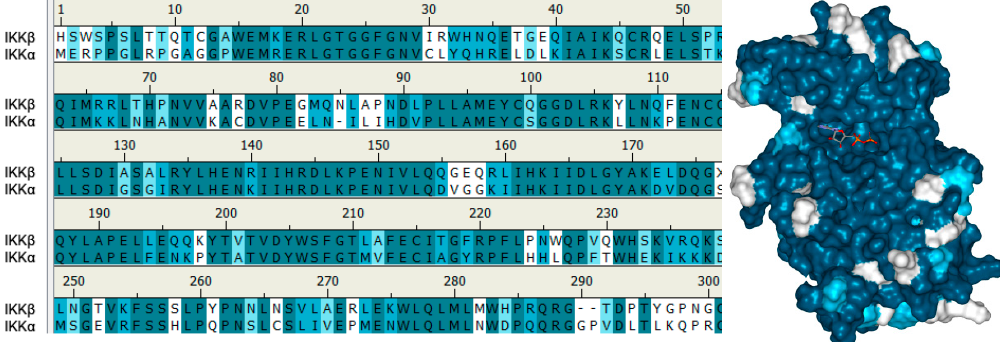
Figure 5. Left : Sequence alignment for the kinase domains of IKK α and IKK β showing 61% of identical residues (coloured in turquoise), a further 14% similar residues (polar for polar, hydrophobic for hydrophobic; in light blue) and 25% non-similar residues (white). X at positions 177 and 181 in IKK β represent the residues in the activation loop of IKK β that have been crystallised containing Ser or phosphoserine residues in the inactive or active conformations respectively. Right : Structure of IKK β highlighting residues that are identical to (turquoise), similar to (light blue) or different from (white) IKK α . The ATP analogue marks the ATP binding site and is surrounded by turquoise residues.